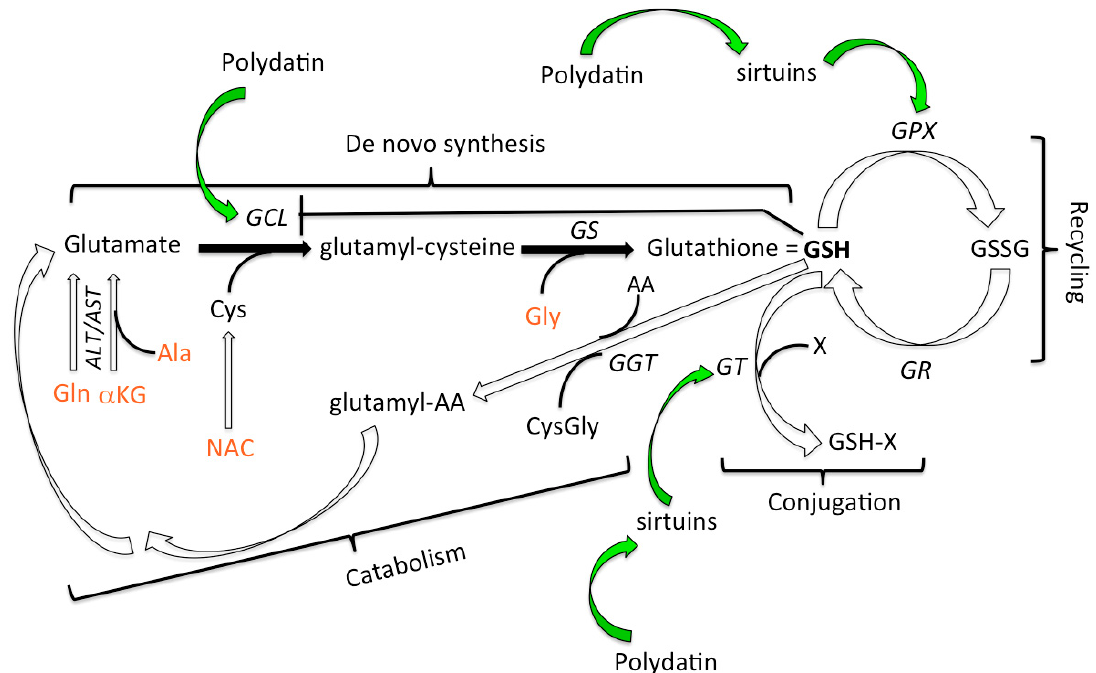
Figure 5. Schematic summary of glutathione synthesis, catabolism, regulation and putative connections with polydatin. Reduced glutathione (GSH) can be produced by continuous recycling mediated by the enzymes glutathione peroxidase (GPX) and glutathione reductase (GR). GPX uses GSH as substrate and oxidizes it to its dimeric oxidized form (GSSG), reducing peroxides and acid peroxides to water and alcohol. GR brings back GSSG to its reduced form GSH which will again be oxidized by GPX, thus leading to the antioxidant status necessary for cellular homeostasis. Instead de novo synthesis of GSH is mediated by glutamate-cysteine ligase (GCL) and glutathione synthetase (GS) when the building blocks (Glutamate, Cys = Cysteine, Gly = Glycine) are available in sufficient quantities. A negative feed-back mechanism exists since GSH inhibits GCL, avoiding unnecessary biosynthesis of GSH. In order to perform its detoxification function GSH is consumed by its conjugation to drugs or other xenobiotics mediated by glutathione S-transferase (GT), whereas its catabolism is initiated by γ -glutamyl transpeptidase (GGT) which yields the CysteinylGlycine (CysGly) dipeptide. Polydatin may impact GSH metabolism either augmenting the quantity or activation of GCL through the Nrf2 pathway or by triggering sirtuins which in turn modulate the activity of GPX and GT. The precursors present in the GluS and GluReS dietary supplements are depicted in red. GSH-X = reduced glutathione bound to a xenobiotic substance; X = xenobiotic substance; AA = aminoacids; NAC = N-acetylcysteine; Ala = alanine; Gln = glutamine; α KG = α -ketoglutarate.